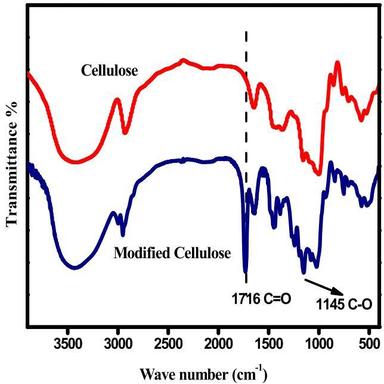
FTIR analysis of cellulose and modified cellulose.